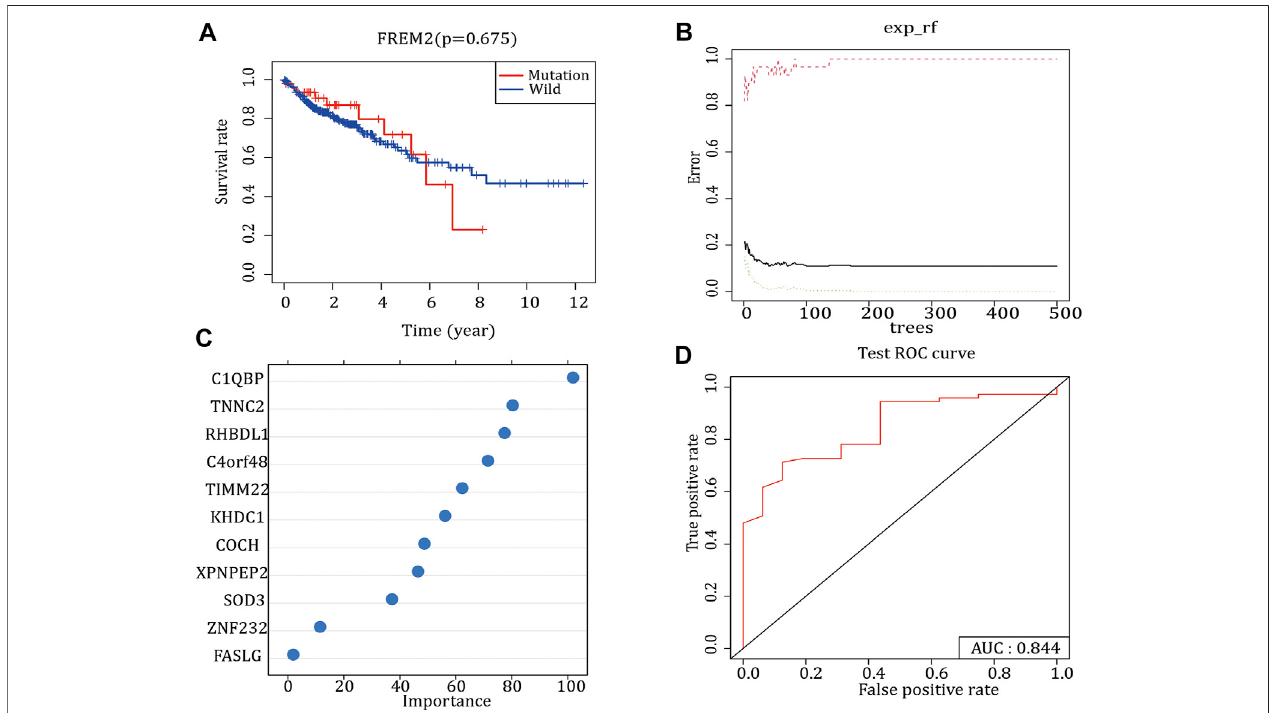
FIGURE 2 | FREM2 mutation survival analysis and model construction. (A) The effect of FREM2 mutation on the overall survival time of the patients. Blue indicates FREM2 -wild type, and red indicates FREM2- mutant type. (B , C) Random Forest method to construct FREM2 mutation model. (D) Performance of the FREM2 mutation model in the test